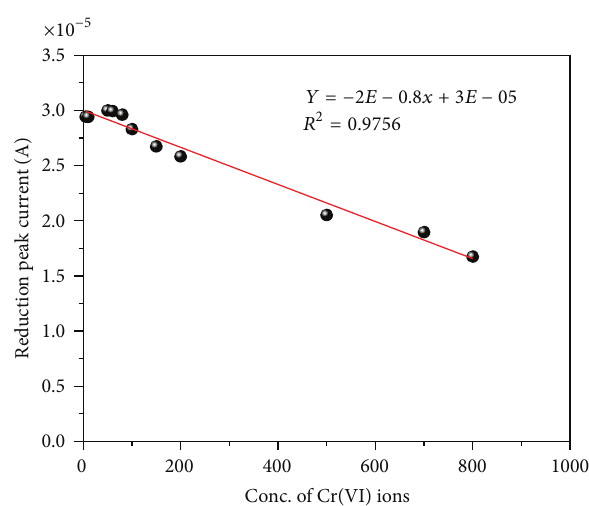
Figure 8: A plot of change in reduction current versus hexavalent chromium ion